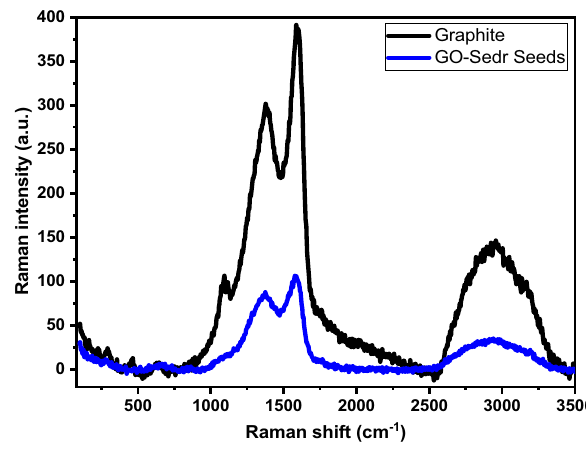
Figure 3. Raman-spectra for graphite and GO- ziziphus Seeds.